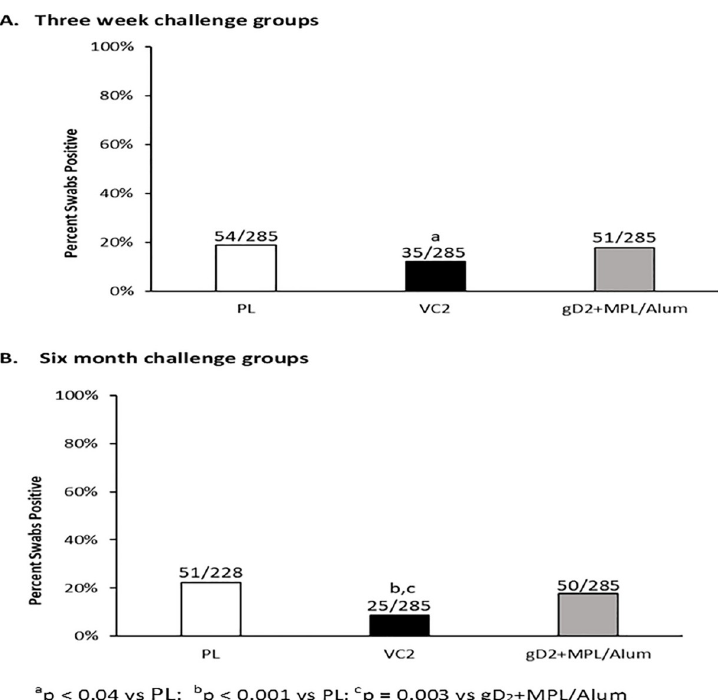
Fig 3. Efficacy of vaccination against recurrent vaginal virus shedding. After recovery from acute disease vaginal swabs were obtained three times per week to assess for HSV-2 shedding by qPCR. Panel A: shows the number of swabs that were positive/the total number of swabs obtained in the groups challenged three weeks post vaccination. Panel B shows the same data for the groups challenged six months after vaccination.